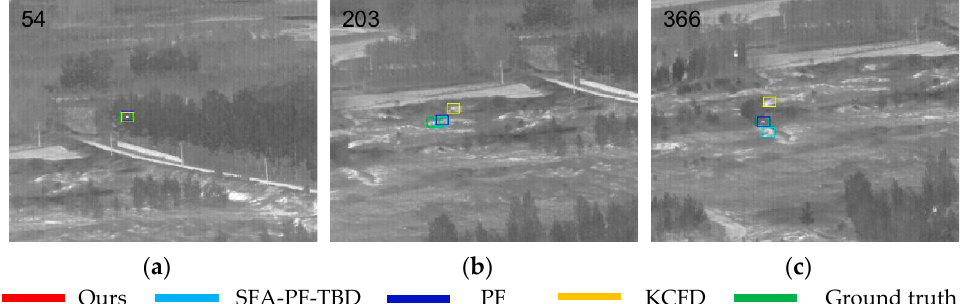
Figure 2. Tracking results of four methods for data8. ( a ) Results at frame 54; ( b ) results at frame 203; ( c ) results at frame 366.